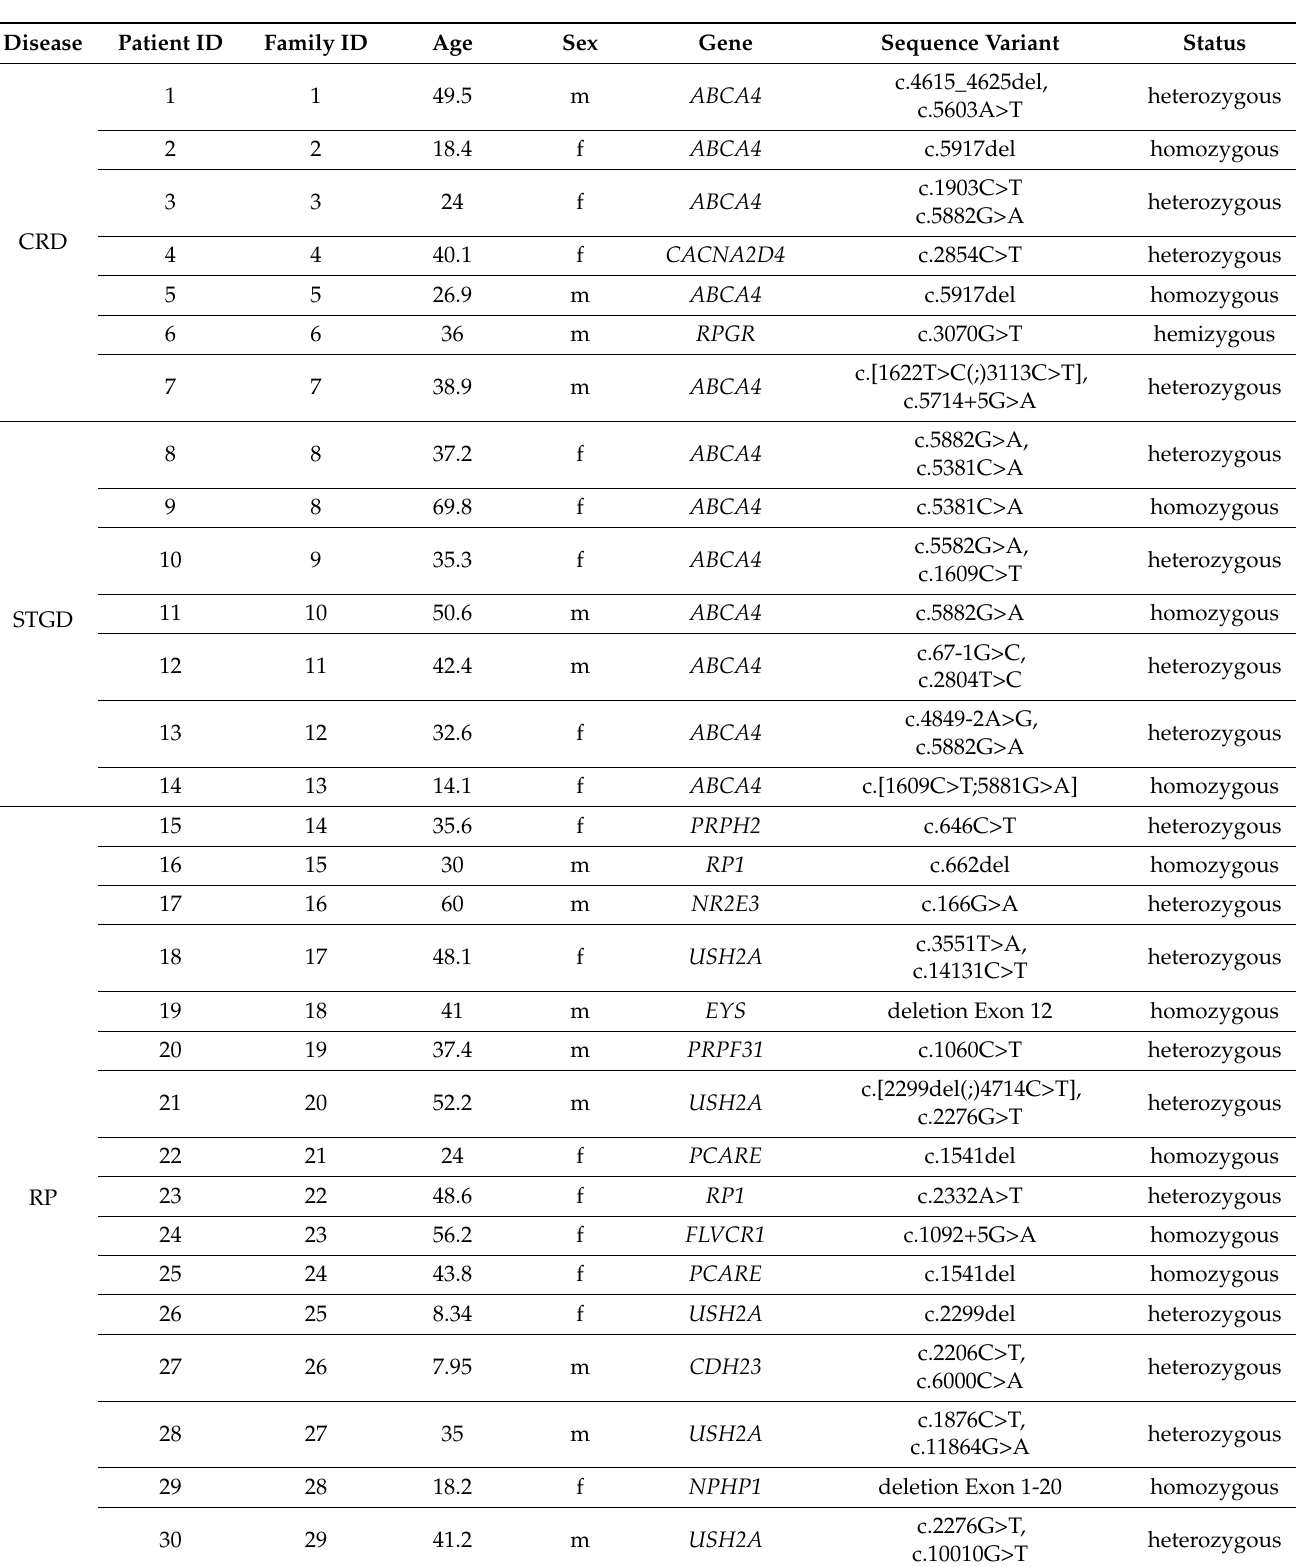
Table 2. Genetic data of all IRD